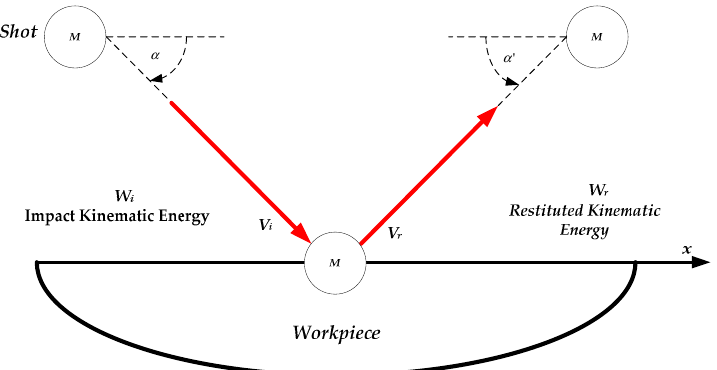
Figure 2. Impact of a single shot with mass m, at the surface of a workpiece showing the restitution of the shot after impact.